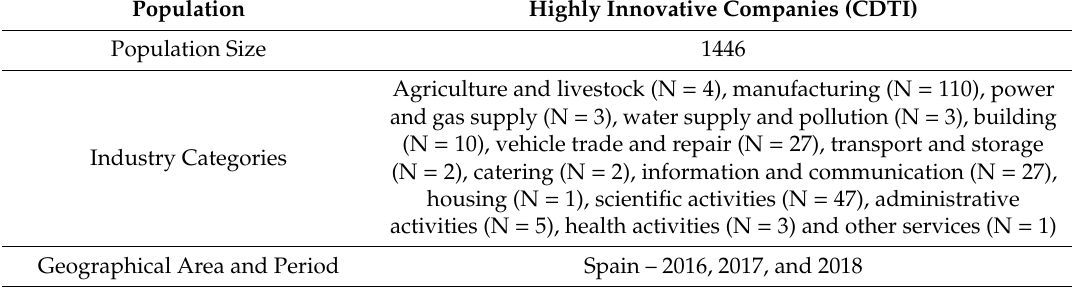
Table 1. Demographic